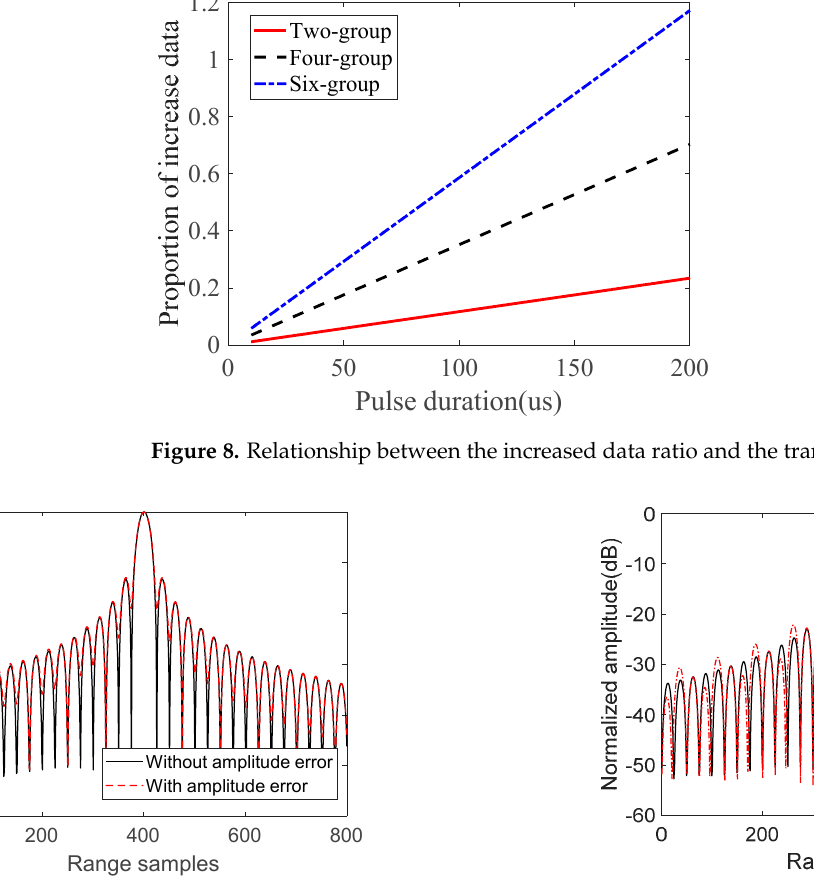
Figure 8. Relationship between the increased data ratio and the transmitted pulse duration.